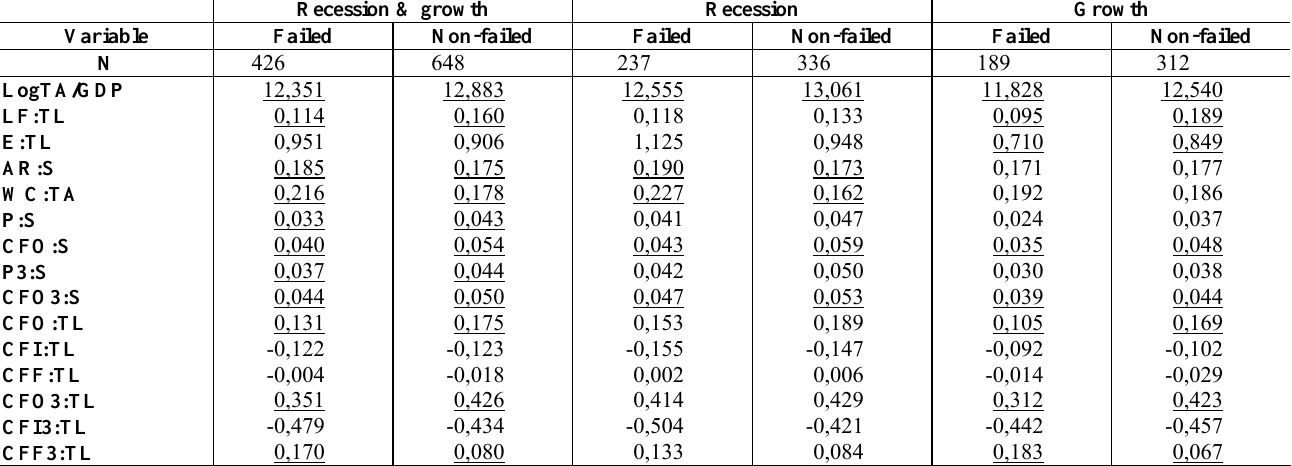
Table 4: Medians of variables for failed and non-failed companies during different economic phases Recession &